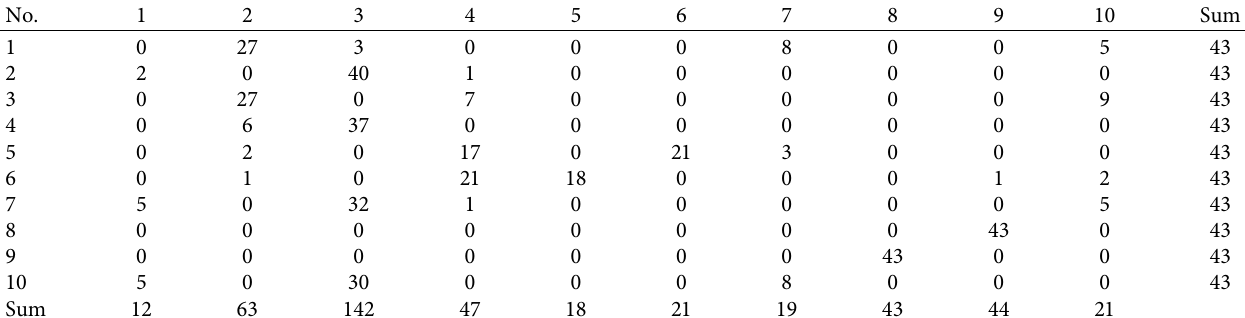
Table 4: The total number of the strongest edges between the 10 sectors in sliding windows.